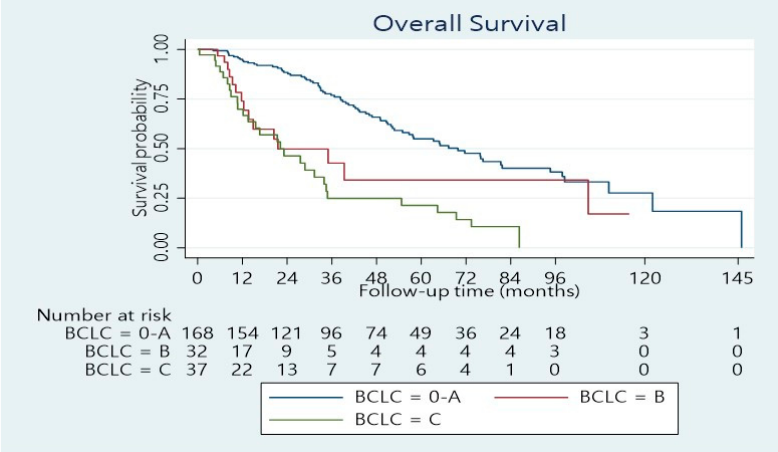
Figure 2. Overall survival distribution stratified according to the BCLC stages ( p < 0.001).